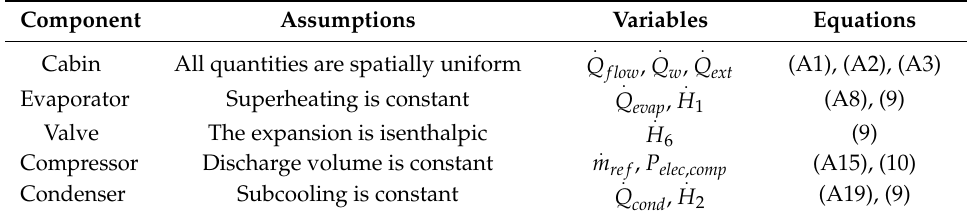
Table A1. Summary of assumptions and variables of the HVAC system